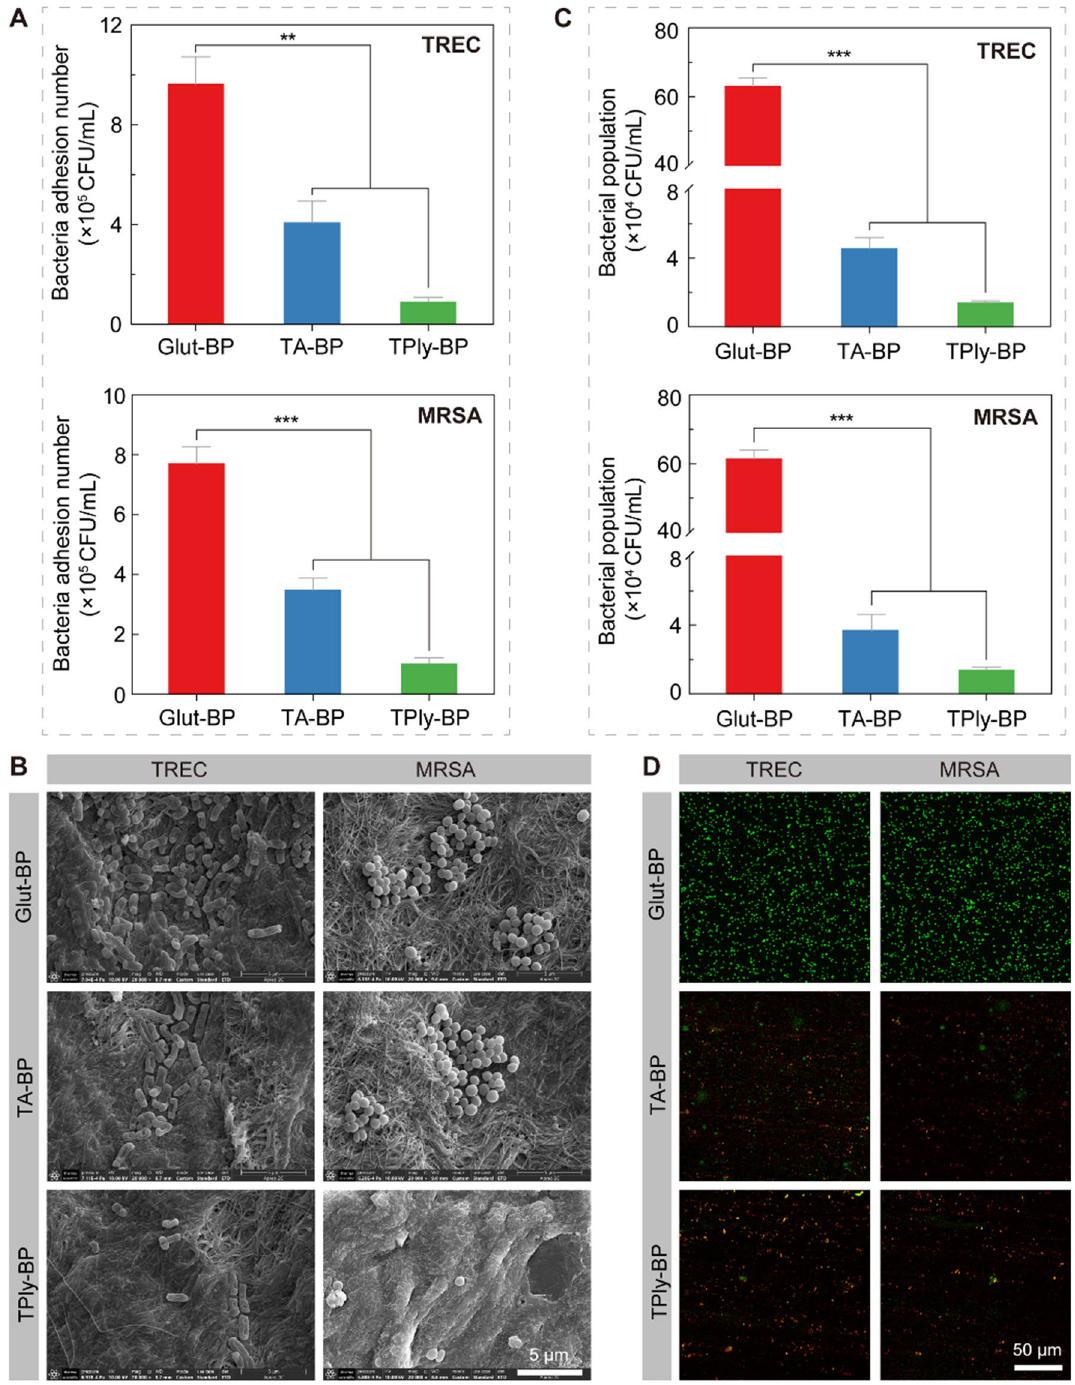
Fig. 4 Antibacterial activity of Glut-BP, TA-BP and TPly-BP. A The number of adhered bacteria on the surface of Glut-BP, TA-BP and TPly-BP. B The morphologies of bacterial adhesion on the valve surface by SEM (20,000 after culturing for 4 h with Glut-BP, TA-BP and